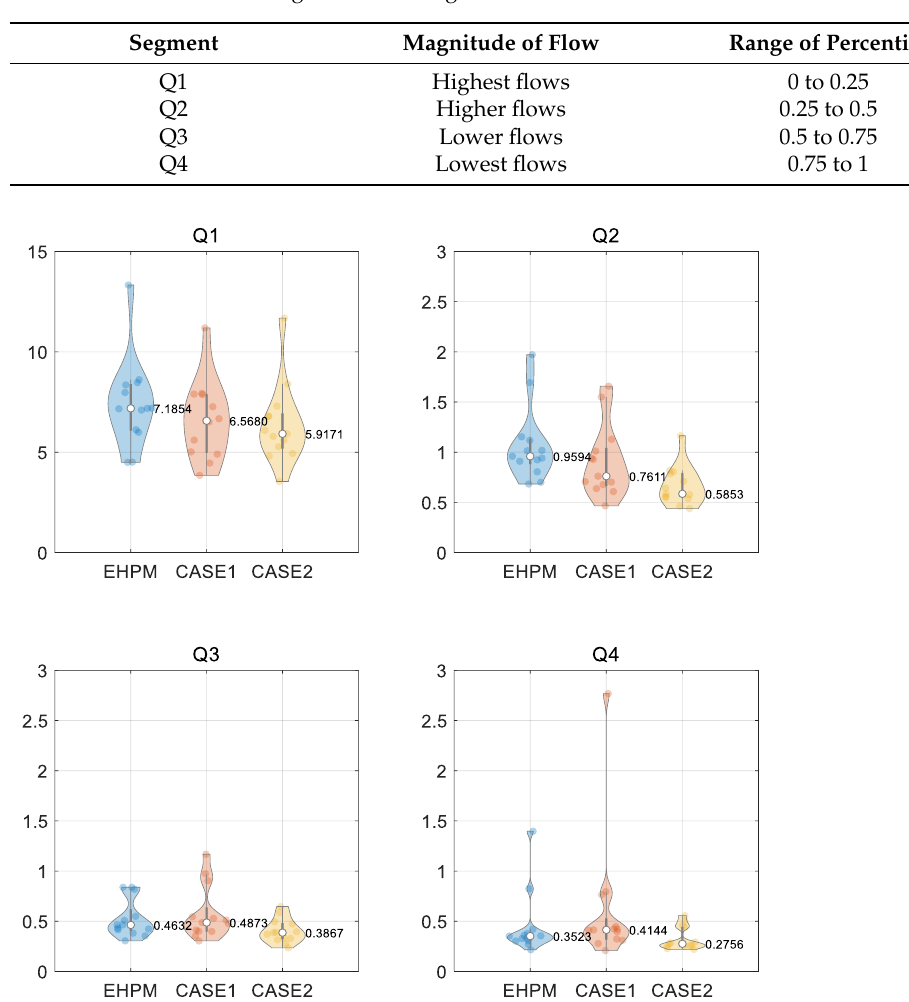
Figure 10. Summary of RMSEs of streamflow predicted from each model for four flow segments. EHPM is the benchmark model, CASE 1 is the separately learned LSTM, and CASE 2 is the integrally learned LSTM. Note that Q1 is the segment for the top 0% to 25% flow magnitude, Q2 is for 25% to 50%, Q3 is for 50% to 75%, and Q4 is for 75% to 100%.